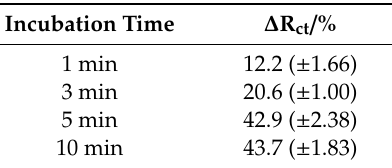
Table 2. Values of R ct change obtained for modified GC electrodes for di ff erent time periods